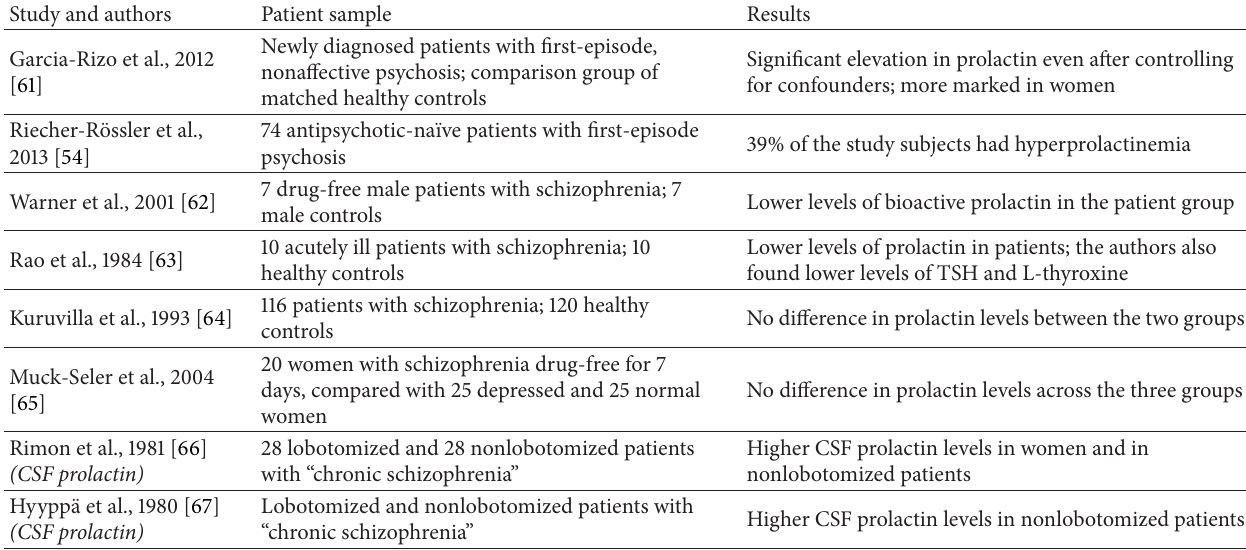
Table 1: Studies measuring prolactin levels in